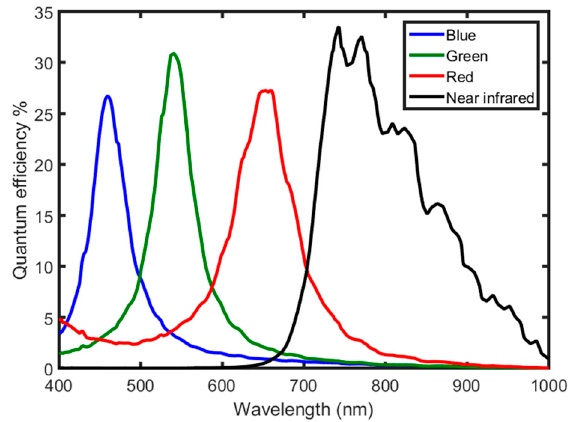
Figure 3. Spectral response of RGB and near infrared (NIR) bands [42]. Table 11. Comparison of SVM classification results using narrow bands and wide bands. Bold numbers indicate better numbers when one compares metrics with the same number of bands. Wide RGB and NIR Bands Based on Spectral Narrow Bands from HS Data Response